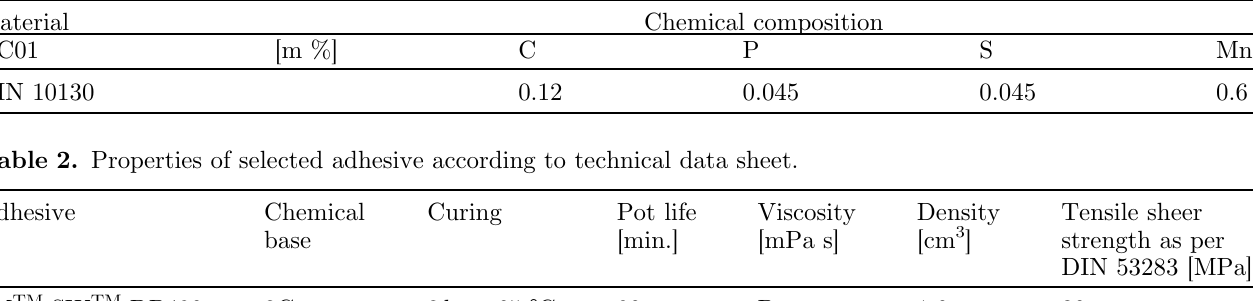
Table 1. Chemical composition of the steel used according to DIN EN 10130. Material